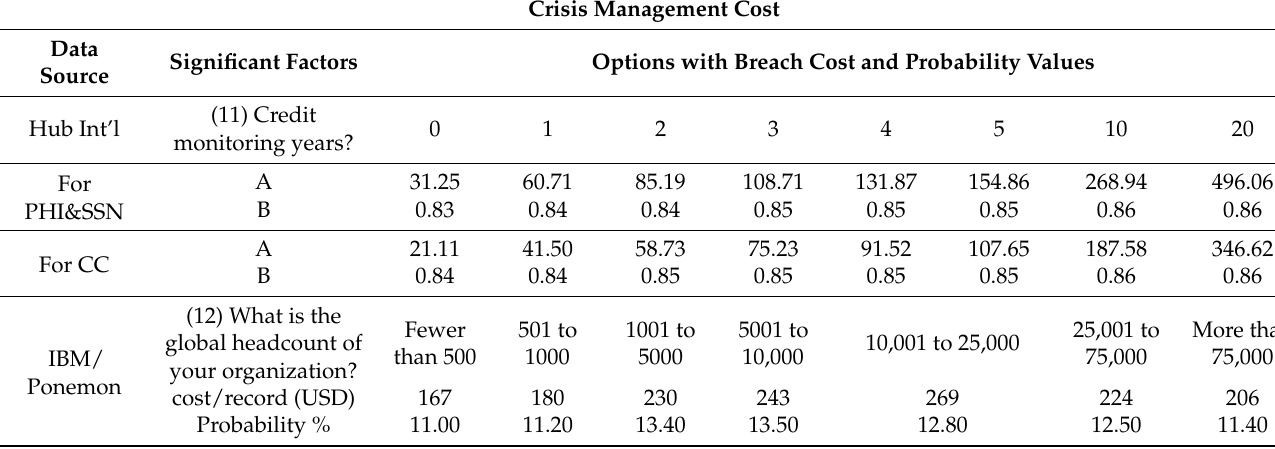
Table 6. The values of data breach costs and the probabilities for the factors associated with crisis management